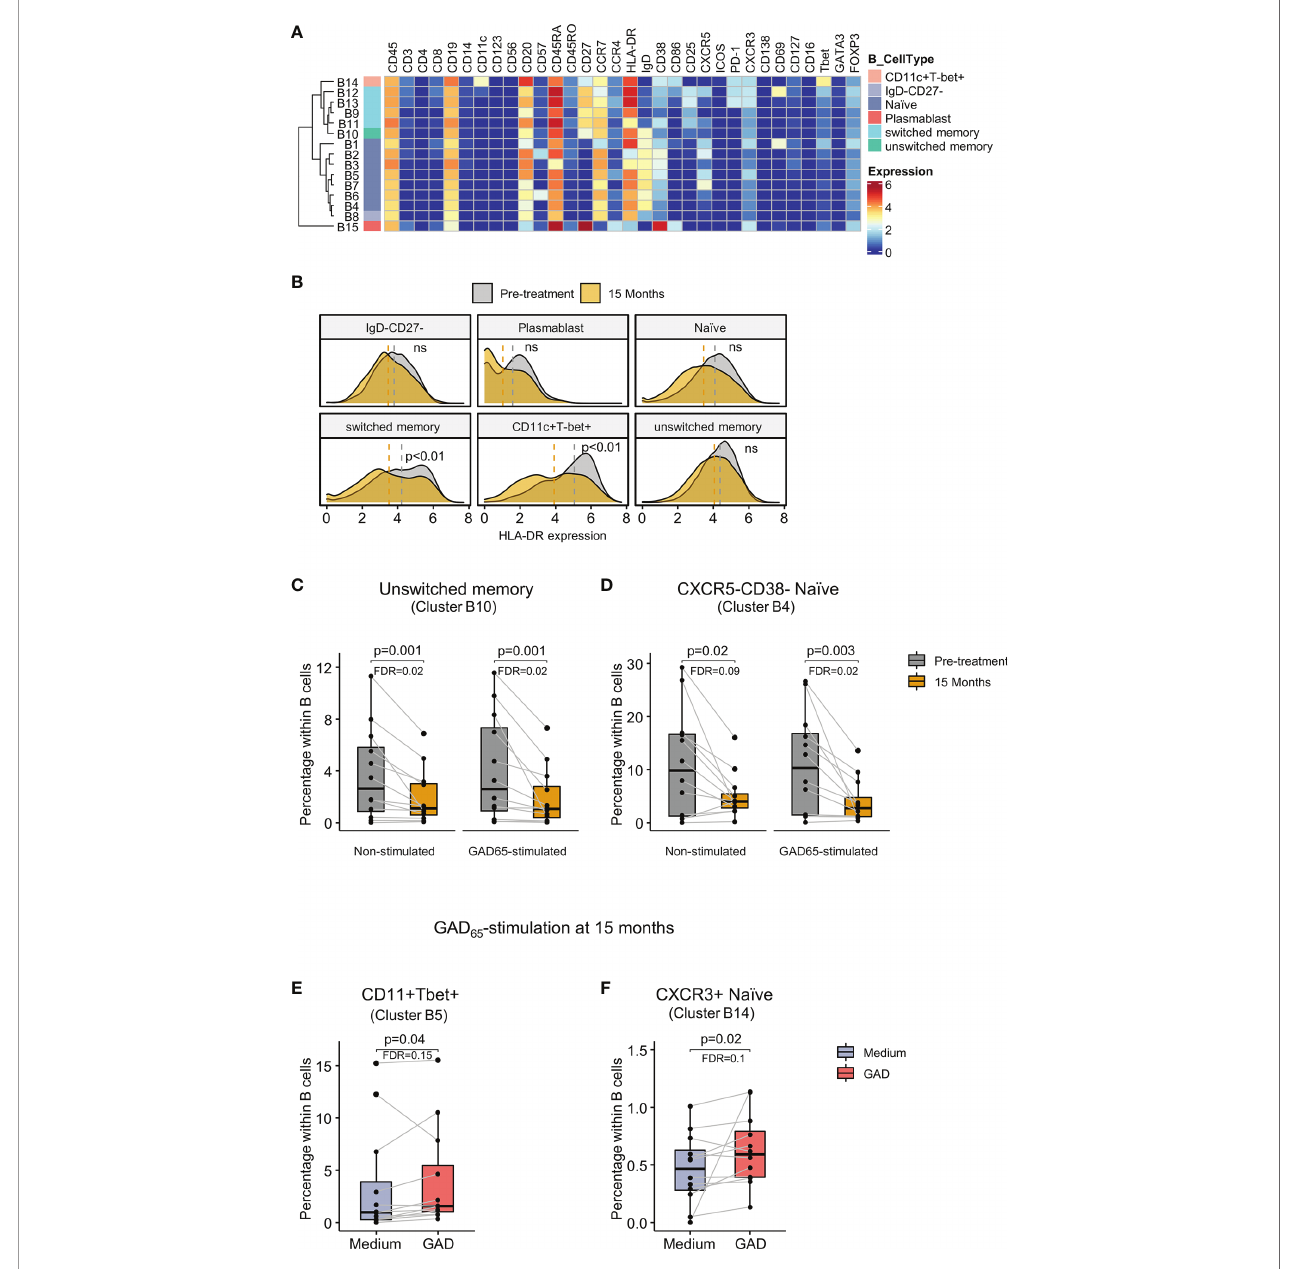
FIGURE 3 | Identi fi cation of B cell clusters and changes after GAD-alum therapy. (A) Heatmap showing median marker expression across the 15 clusters identi fi ed within B cells. (B) Histogram depicting the density of HLA-DR expression on naïve, IgD-CD27-, plasmablast, switched memory, unswitched memory and CD11c+Tbet+ B cells before (grey) and after treatment (yellow). Dashed lines indicate median expression. (C) Median Proportion of CD27+IgD+ unswitched memory B cells (cluster B10) before (grey) and after treatment (yellow) in non-stimulated and GAD 65 -stimlated samples. (D) Proportion of CXCR5-CD38- naïve B cells (cluster B4) before (grey) and after treatment (yellow) in non-stimulated and GAD65-stimulated samples. Proportion of (E) CD11c+Tbet+ B cells (cluster B5) and (F) CXCR3+ naïve B cells (cluster B14) in 15 months samples cultured in medium alone (blue) or in the presence of 5 m g/ml of GAD 65 (red) for 72 hours. Dots represent individuals and boxplots indicate median and interquartile range. Wilcoxon signed-rank test. p < 0.05 was considered signi fi cant. FDR, False discovery rate (Benjamini – Hochberg). ns: non signi fi